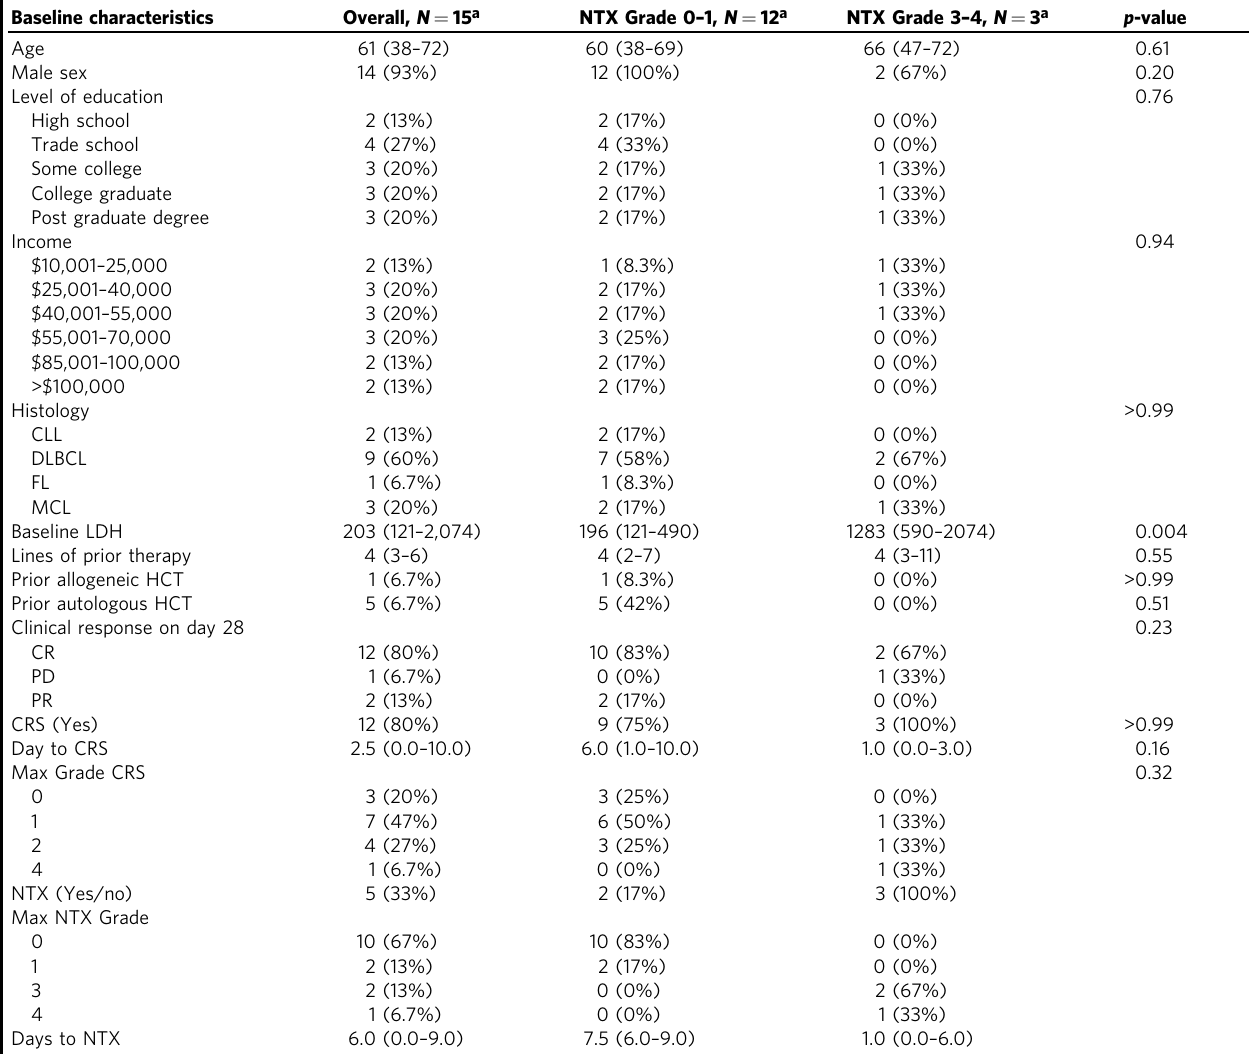
Table 1 Baseline patient demographics.